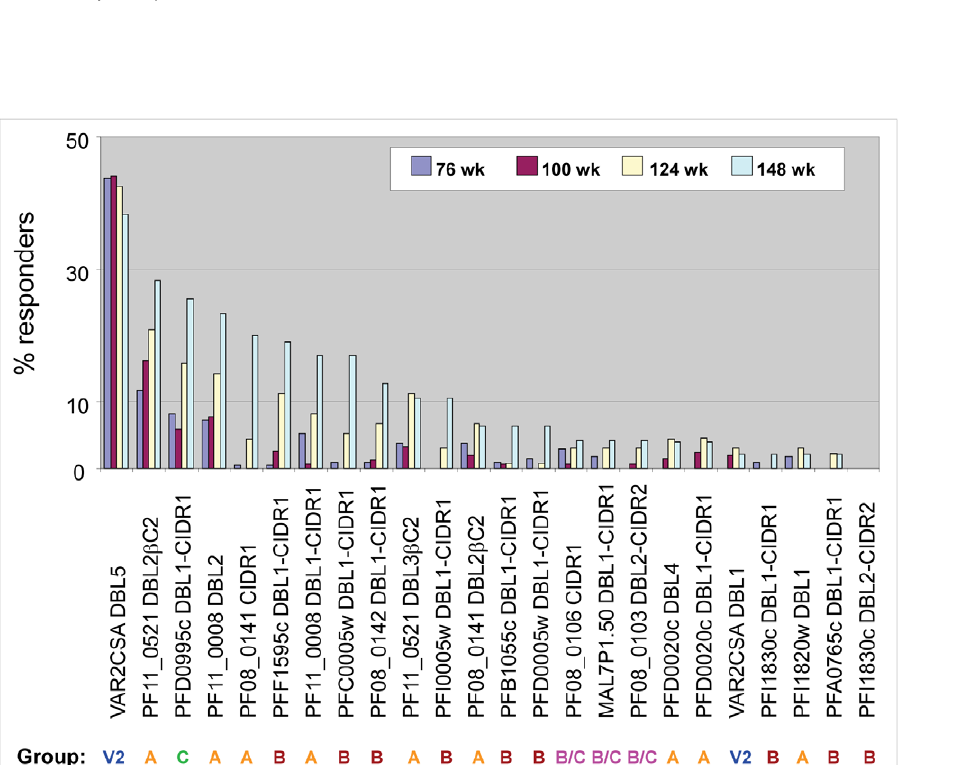
*Domains cloned into pAdEx, other domains cloned into pHisAdEx. Abbreviations: AU, Arbitrary Units; SD, Standard Deviation; NT, Not Tested.